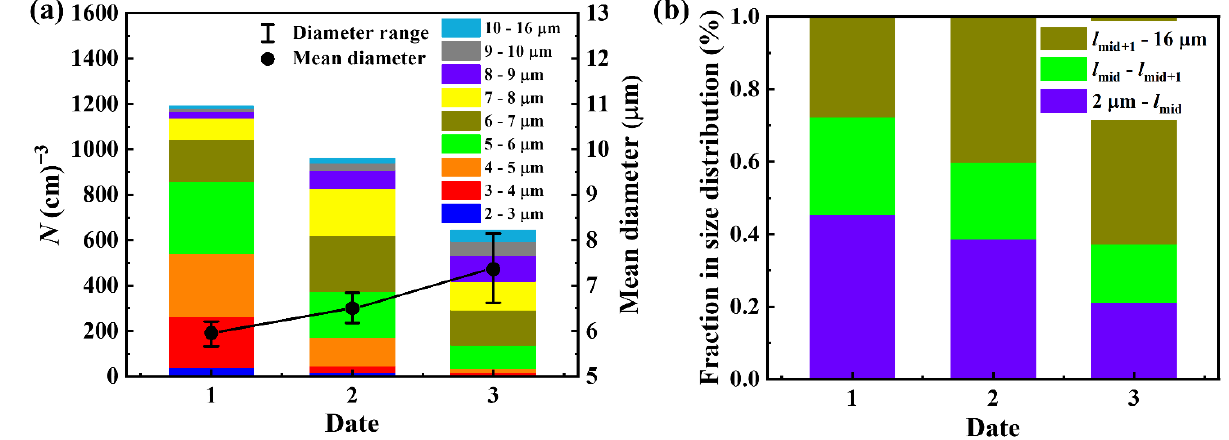
Figure 10. The average statistical results of DSD in three experiments. ( a ) The number concentration distribution of nine size channels. ( b ) The proportion of three types of droplets: smaller, medium, and oversized droplets.